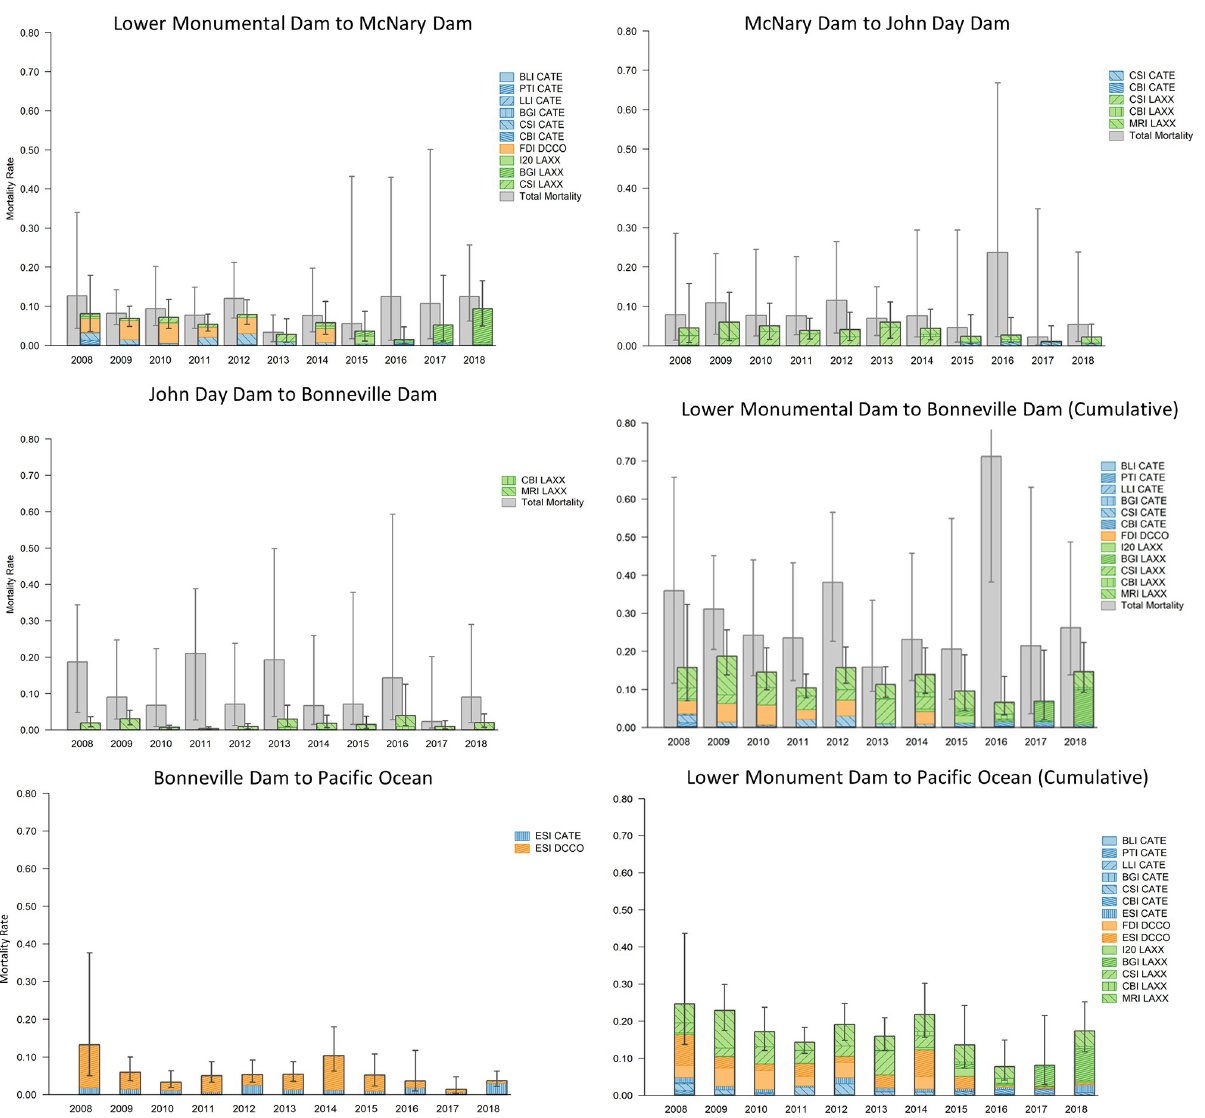
Fig 5. Avian consumption and total mortality of snake river sockeye salmon. Estimated annual colony-specific, reach-specific, and cumulative avian consumption probabilities (colored bars) and total mortality (grey bars) of Snake River sockeye salmon during passage from Lower Monumental Dam on the Snake River to the Pacific Ocean. Colony locations include Banks Lake Island (BLI), Potholes Reservoir (PTI), Lenore Lake Island (LLI), Island 20 (I20), Foundation Island (FDI), Badger Island (BGI), Crescent Island (CSI), Blalock Islands (BKI), Miller Rocks (MIR), and East Sand Island (ESI). Avian species include Caspian terns (CATE), double-crested cormorants (DCCO), and California and ring-billed gulls (LAXX). Error bars represent 95% credible intervals for total mortality and avian